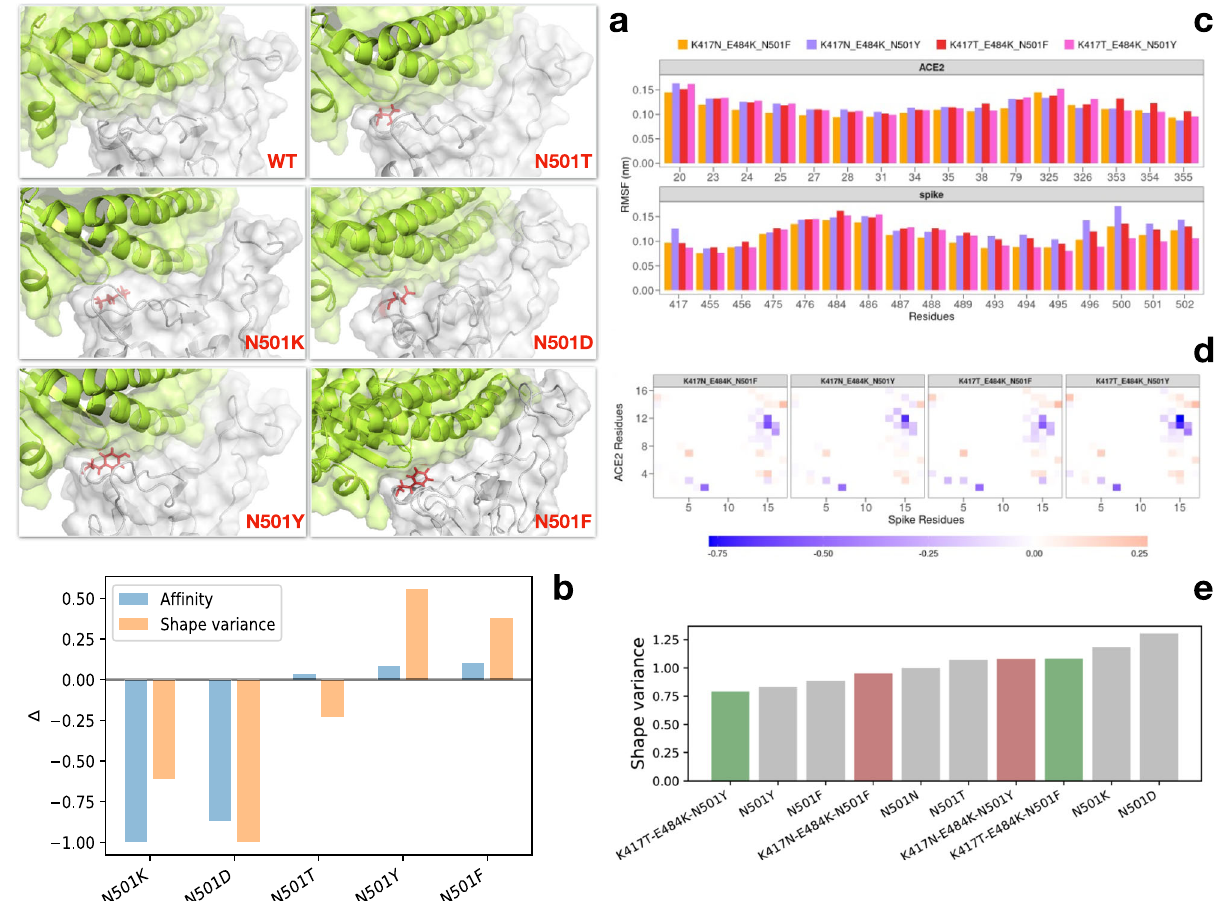
Fig. 6 Analysis of the shape complementary of the binding regions. a Cartoon representations of the binding region of the complex formed by SARS- CoV-2 spike protein (gray) and human ACE2 receptor (green) for the wild-type complex and the fi ve single-mutation variants. The spike residue 501 is represented with red sticks. The molecular surfaces for both spike and ACE2 are shown. b Experimental af fi nity values (taken from ref. 27 ) for the spike- ACE2 complexes (blue bars) and shape variance as measured by the Zernike descriptors on molecular dynamics con fi gurations (orange bars). Both quantities are obtained by difference with respect to the reference complex data (see Table 1). c Root mean square fl uctuations (RMSF) of ACE2 (top) and SARS-CoV-2 spike (bottom) protein residues found in interaction during the dynamics for the South African and Amazonian variants together with the two versions carrying phenylalanine at position 501. d Difference between the contact probability matrices of the interacting residues between each three- mutation spike variant and the Wuhan (WT) one (see Table 1). Residues are considered as interacting if the distance between their α -carbons is lower than 9 Å . e Shape variance as measured by the Zernike descriptors on molecular dynamics con fi gurations for all the variants reported in Table